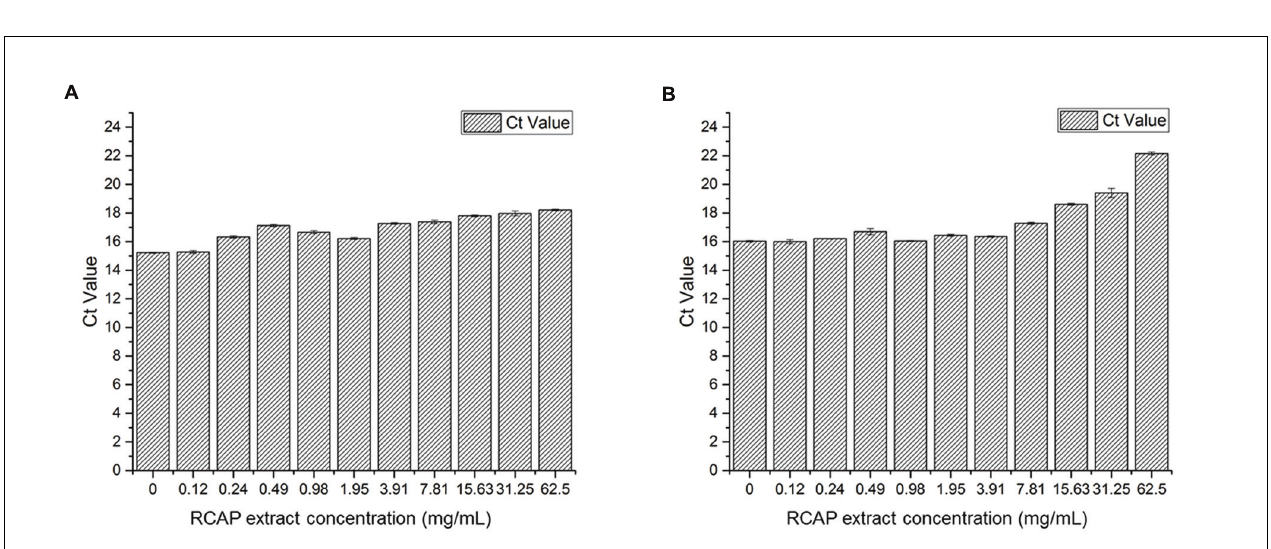
FIGURE 4 | Quantification of rotavirus by real time qPCR assay (A) Viral load in each group of mixed treatment assay; (B) Viral load in each group of post treatment assay. C t values can be used as a quantitative measurement of the input target number which reflects the viral load in antiviral assay, and there was a negative relationship between C t value and the viral